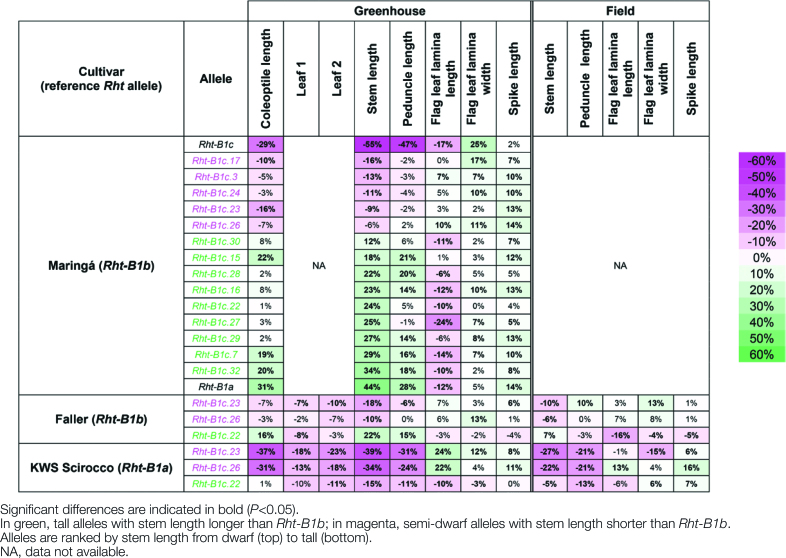
Effect of ovg alleles on elongation in different wheat cultivars, in the greenhouse and fieldPercentage average difference of phenotypic traits for each ovg allele, relative to the reference allele, are shown. The scale next to the table details the intensity of color saturation for percentage difference.